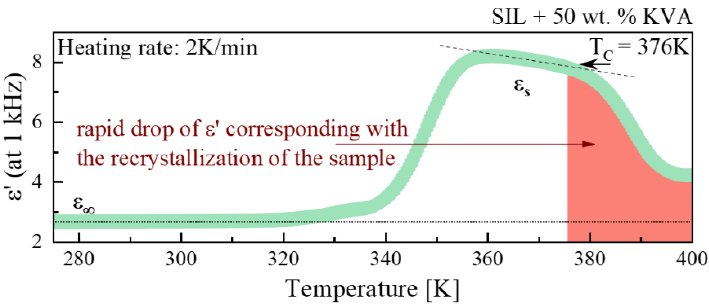
Figure 5. The evolution of the dielectric constant ε′ at 1 kHz, as measured for SIL + 50 wt.% KVA upon heating at a 2 K/min rate. Red dashed area corresponds to the sample recrystallization process.